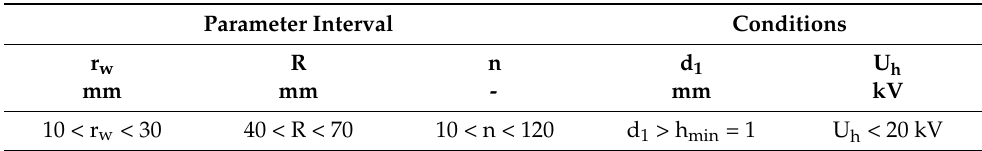
Table 3. Intervals and conditions concerning the